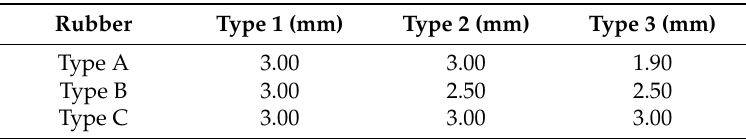
Table 3. Thickness of created MCF